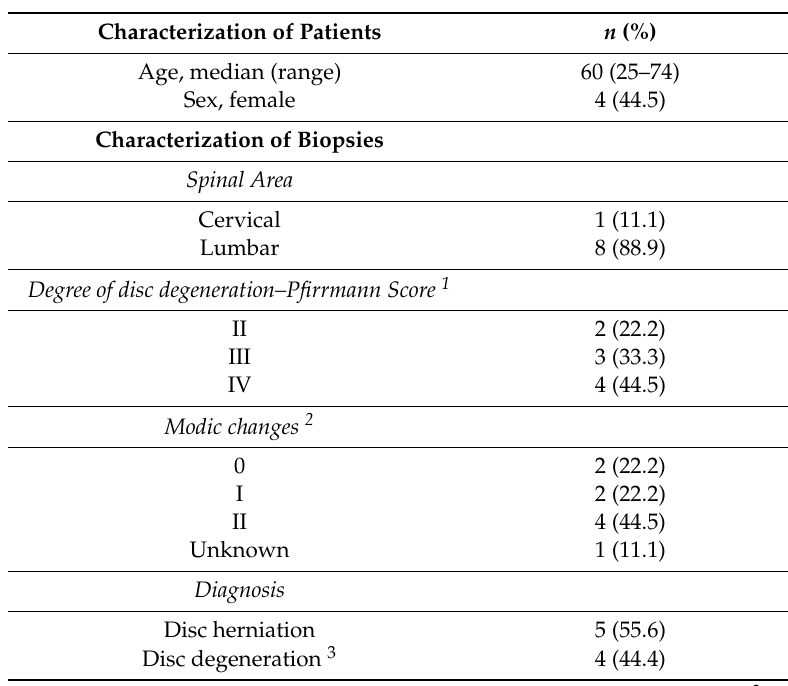
Table 2. Characterization of 9 patients providing biopsies for IVD